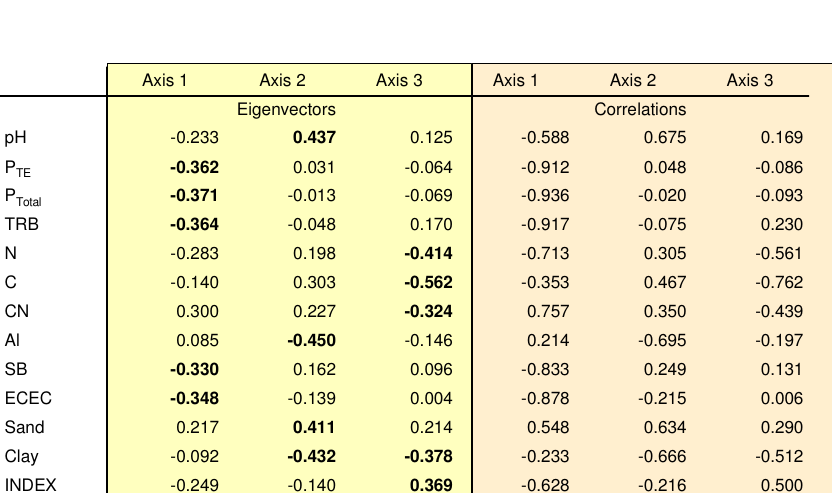
Fig. 16 Fig. 16. Principal coordinates analyses for soil variables in this